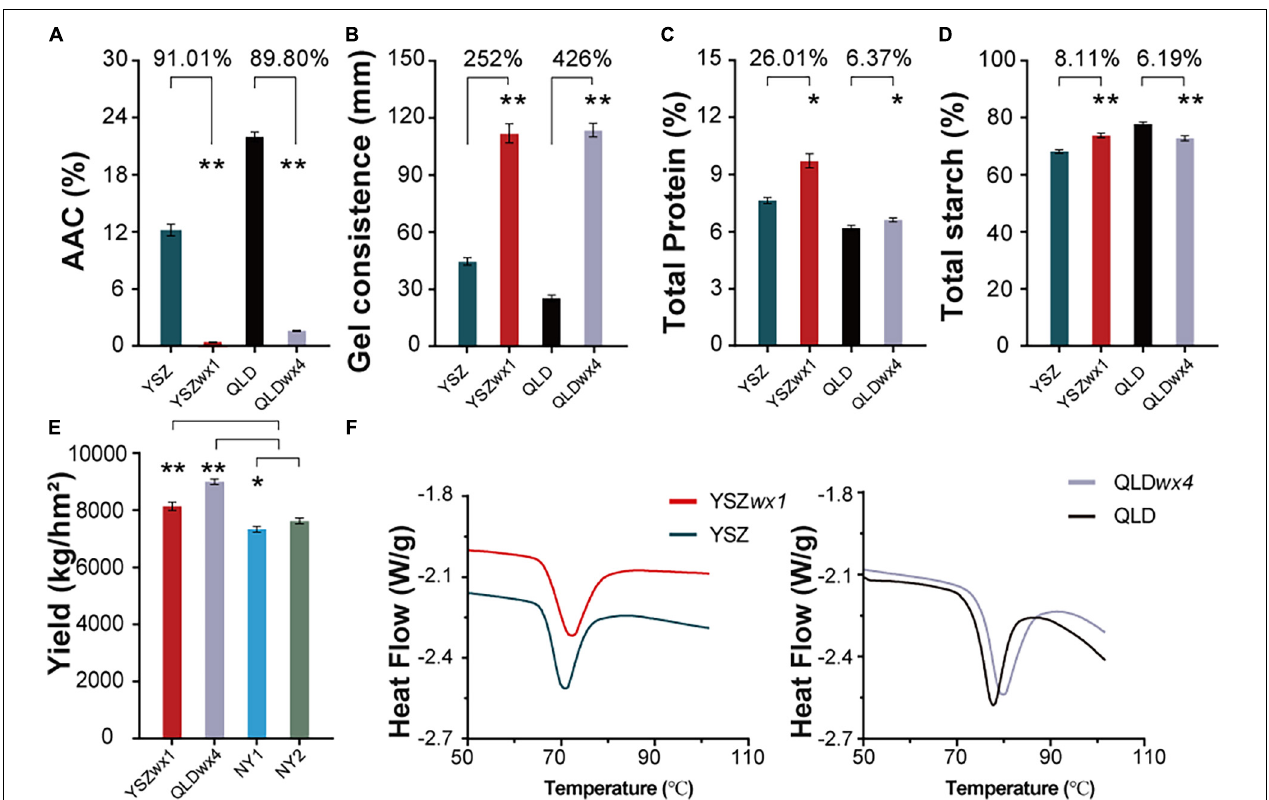
FIGURE 2 | Apparent amylose content (AAC), gel consistency (GC), total protein, total starch, grain yield, and gelatinization properties of wx mutants and their corresponding WT lines. (A) AAC of wx mutants and their corresponding WTs. (B) GC of wx mutants and their corresponding WTs. (C) Total protein of wx mutants and their corresponding WTs. (D) Total starch of wx mutants and their corresponding WTs. (E) The grain yield of wx mutants of NY1 and NY2. NY1 is a japonica waxy rice (in blue), NY2 is an indica waxy rice (in green). (F) Gelatinization properties curve in wx mutants and their corresponding WTs. Error bars are mean ± SD ( n = 3). Significant differences were determined by Student’s t -test (* P < 0.05, ** P <